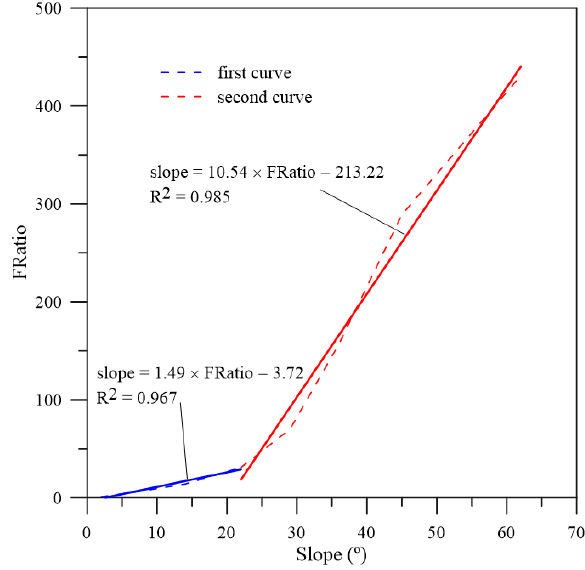
Figure 2. Example of RFR for Castellon province.